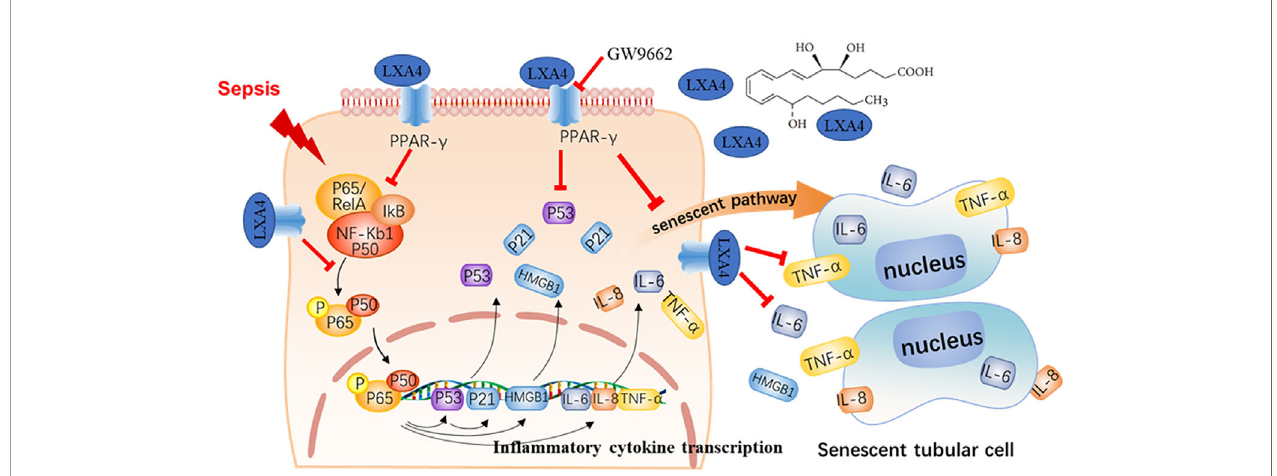
FIGURE 7 | LXA4 attenuates septic AKI via blocking crosstalk between in fl ammation and premature senescence in PPAR- g -dependent manner. Sepsis would cause activation of NF- k B-mediated in fl ammation response and NF- k B/p53 mediated cellular premature senescence in kidney tissues. The in fl ammation response interplays with cellular premature senescence in septic AKI. Pretreatment with LXA4 promotes in fl ammation resolution and blocks the crosstalk between in fl ammation and premature senescence via PPAR- g /NF- k B